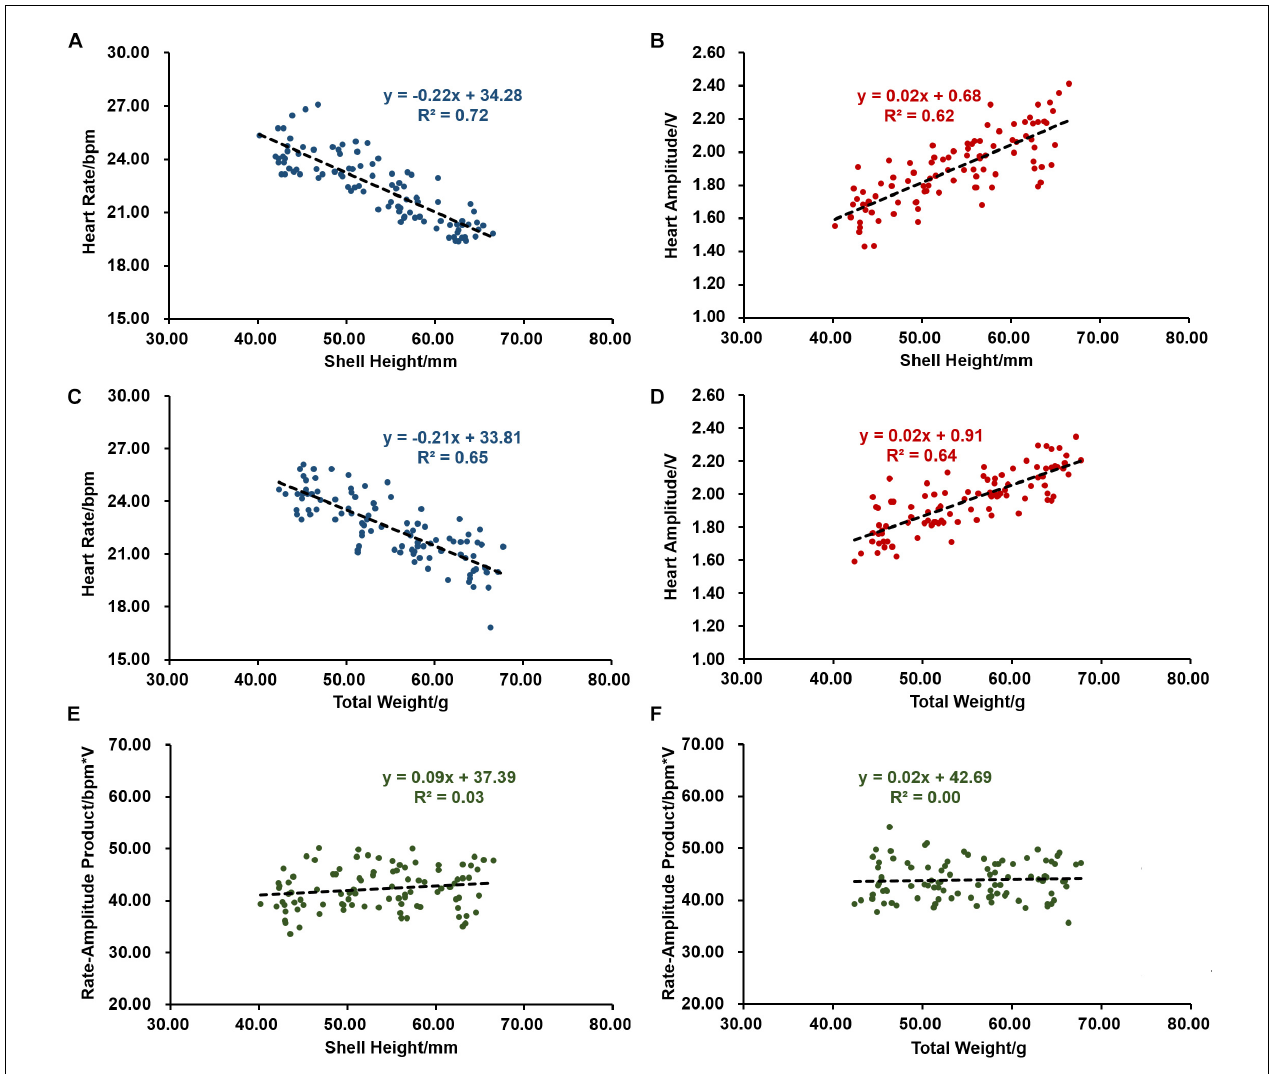
FIGURE 1 | The effects of size on cardiac activity ( N = 96). (A) The negative correlation between heart rate (HR) and shell height. (B) The positive correlation between heart amplitude (HA) and shell height. (C) The negative correlation between HR and total weight. (D) The positive correlation between HA and total weight. (E) Correlation between rate-amplitude product (RAP) and shell height. (F) Correlation between RAP and total weight.